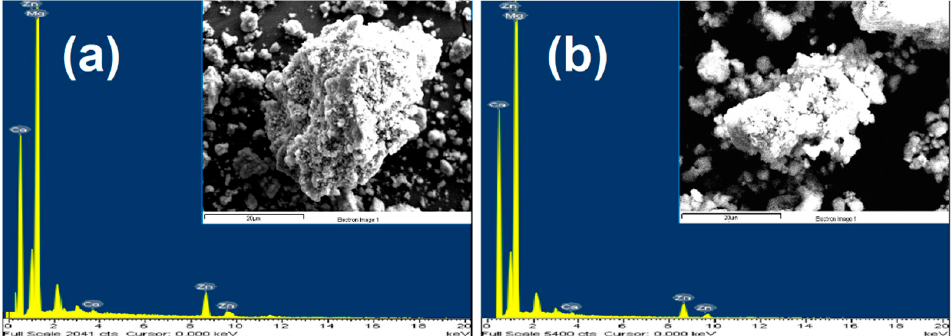
Figure 3. SEM micrographs of Mg70–Zn25–Ca5 milled for ( a )15 and ( b ) 20 h. Reprinted from Ref. [25]. Physics SRL, 2021.